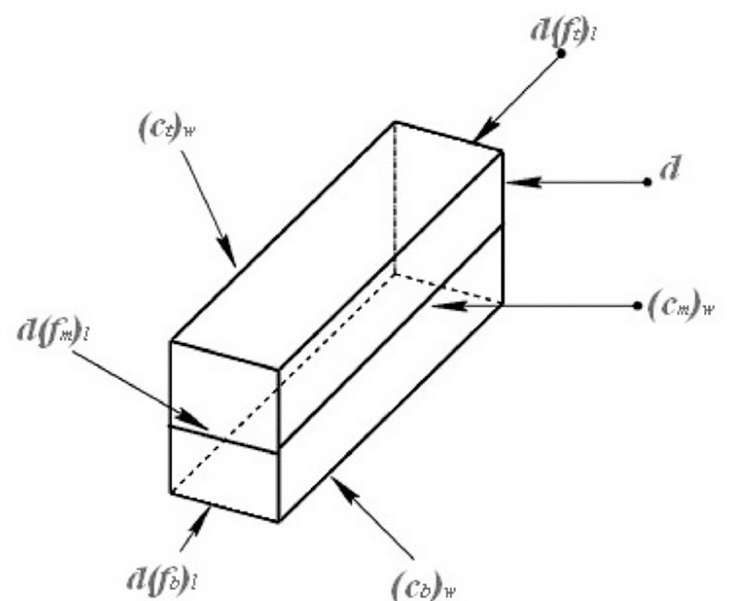
Fig 5. The size of the soil